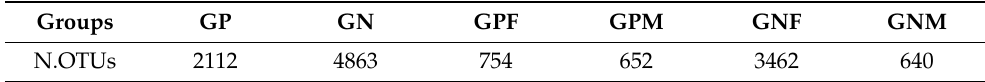
Table 1. Unique OTUs per